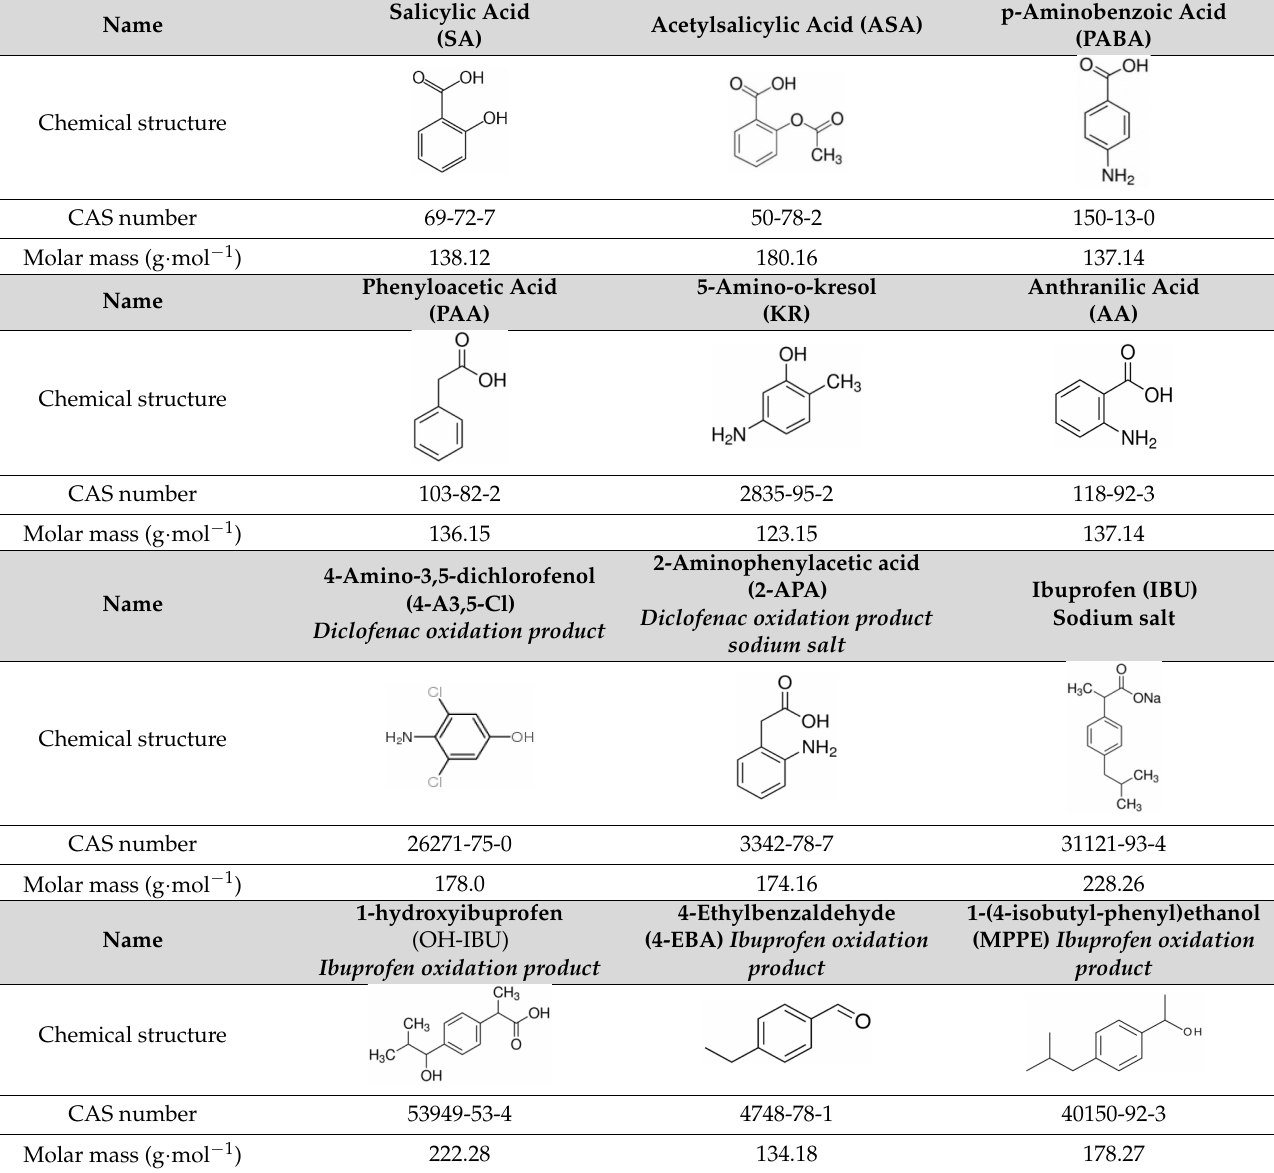
Table 1. Structural formulas of selected